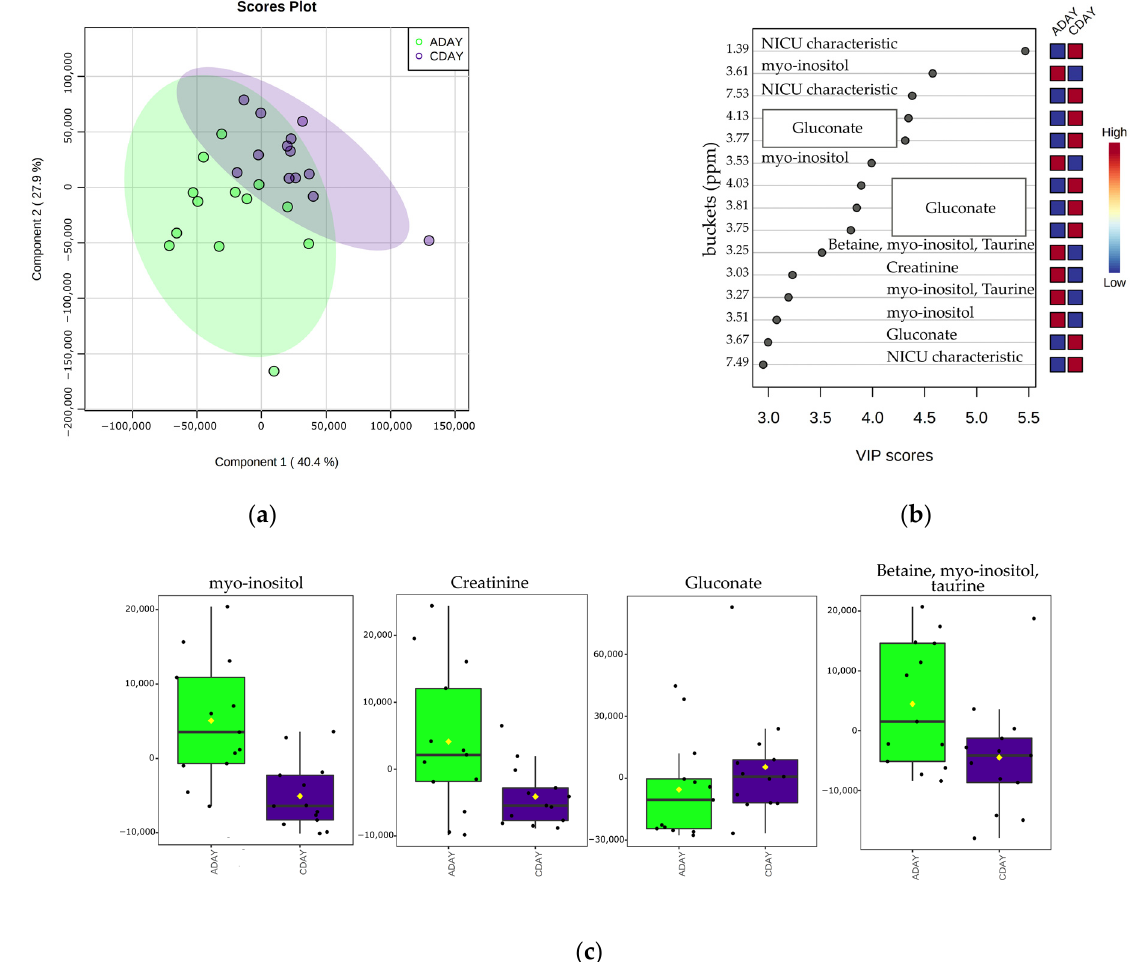
Figure 4. Multivariate analysis of NMR data belonging to urine samples of neonates diagnosed with EOS the first (green circles) and the third day (blue circles) of their life. ( a ) PLS-DA scores plot of the first- and third-day’s samples. ( b ) VIP scores and metabolites related to buckets with different concentration among the two groups. ( c ) Box plots of normalized concentration for the discriminant